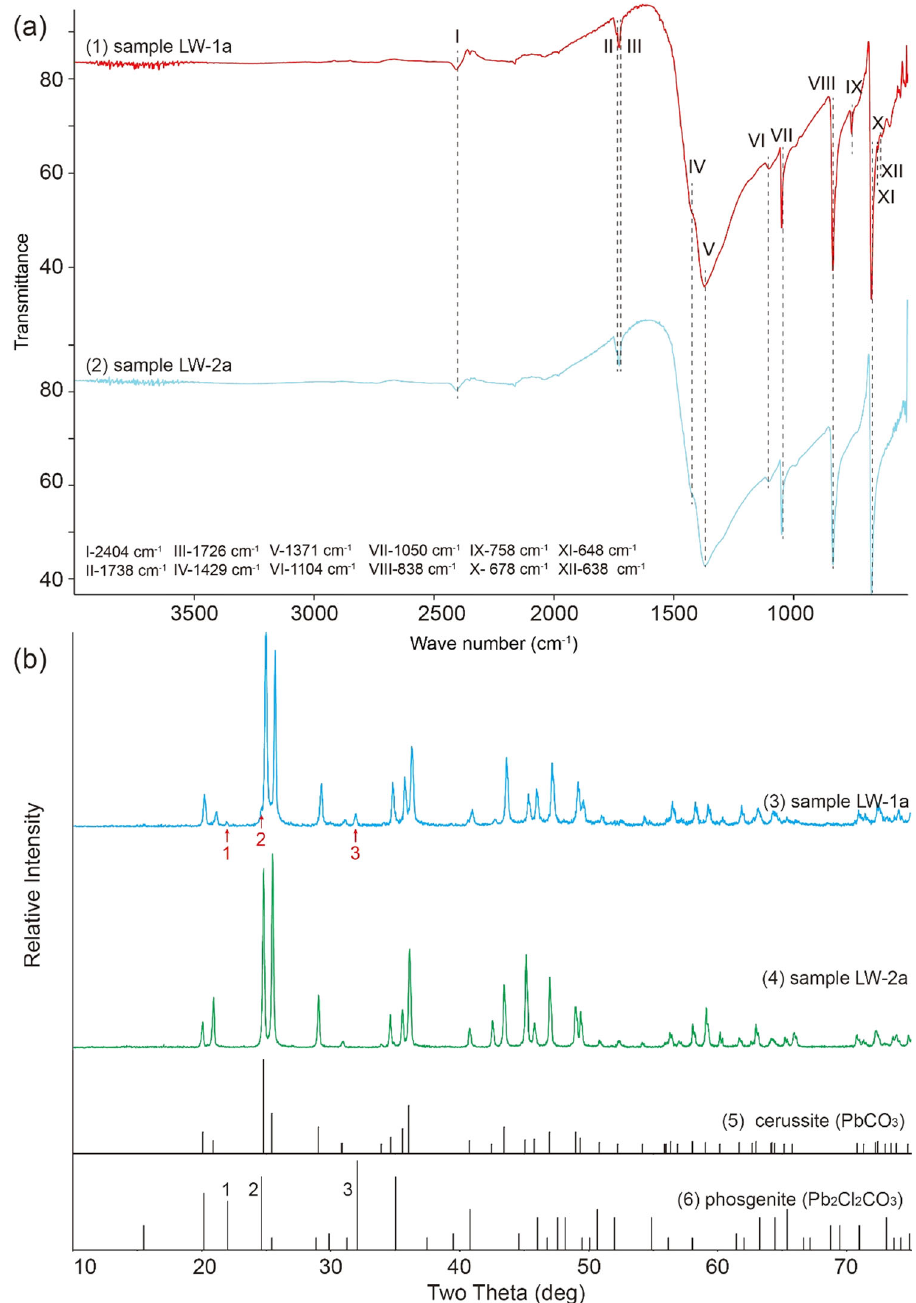
Fig. 5 FTIR and XRD analysis of white residues. a FTIR analysis: (1) sample LW-1a and (2) sample LW-2a. b Powder X-ray diffraction patterns: (3) sample LW-1a and (4) sample LW-2a. (5) and (6) are reference patterns for cerussite (PbCO 3 ) and phosgenite (Pb 2 Cl 2 CO 3 ),